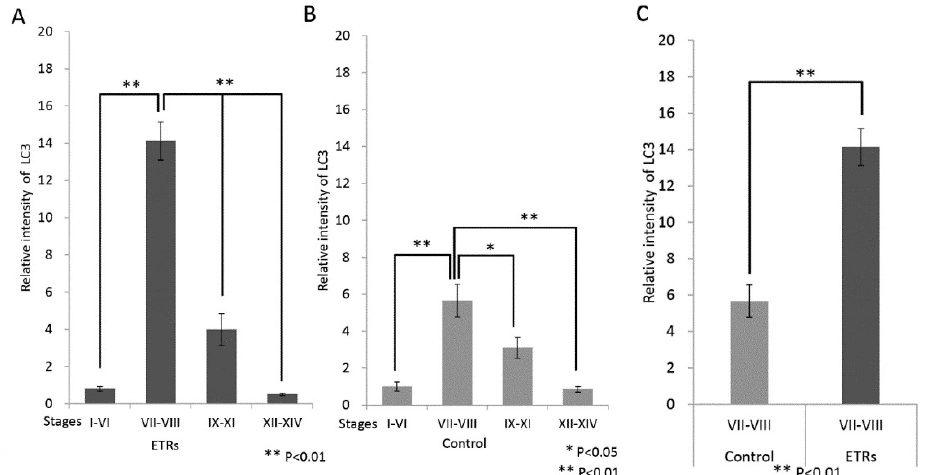
Figure 3. Quantification of LC3 expression in SCs at various stages of the spermatogenic cycle. ( A ) Histogram demonstrating quantification of LC3 intensity in SCs of ETRs at various stages based on IHC analysis from Image J software (highest in stages VII–VIII for ETRs); ( B ) Histogram showing LC3 quantification in control group; ( C ) Histogram demonstrating higher intensity of LC3 expression in stages VII–VIII in ETRs compared to the control. (* p < 0.05; ** p < 0.01) ( t -test).